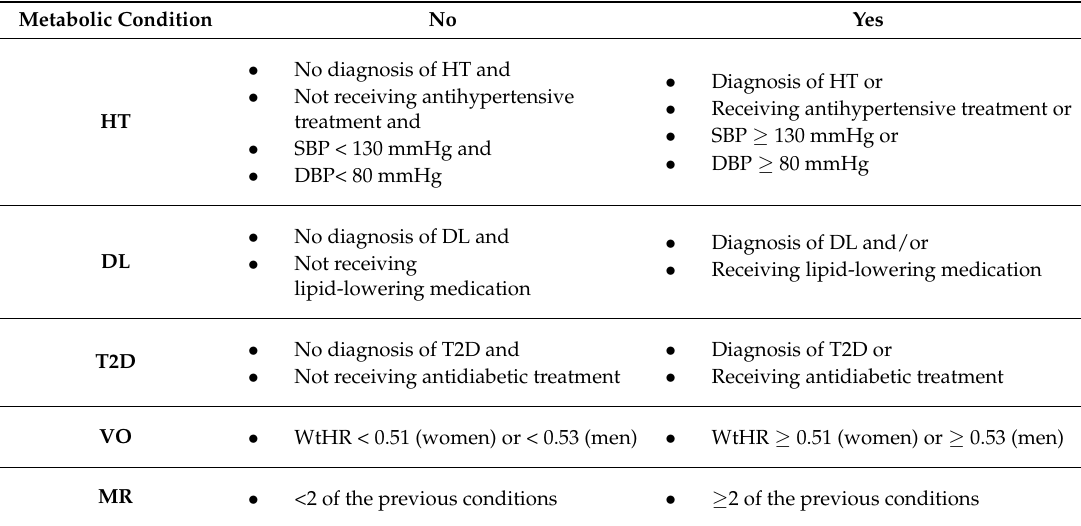
Table 2. Criteria used to assess the health status and risk of the subjects 1